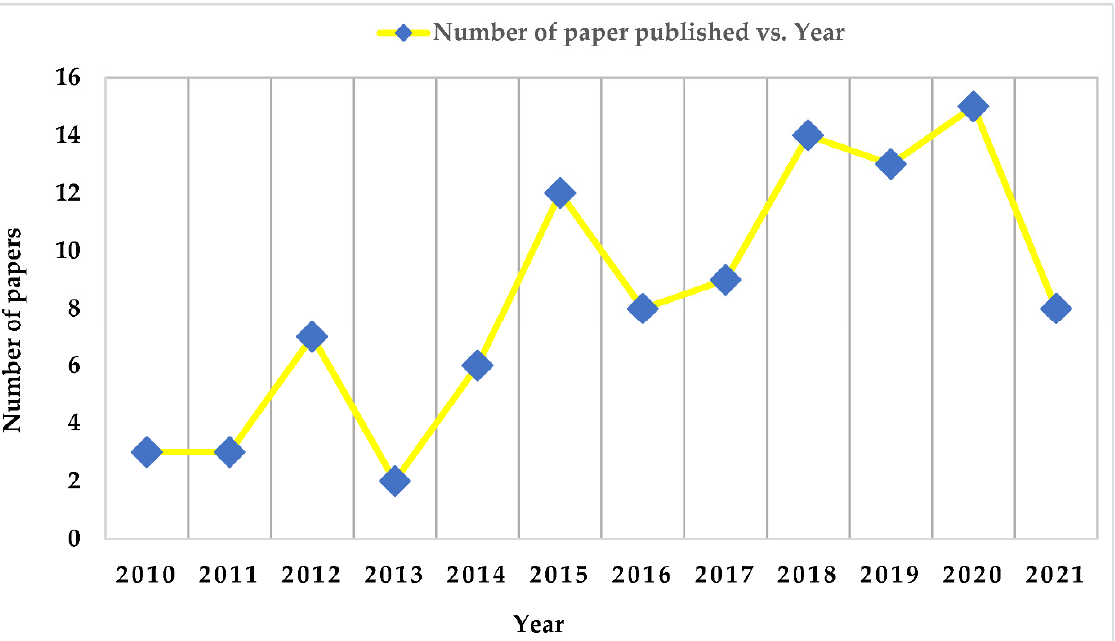
Figure 4. Distribution of 100 top-cited manuscripts from the year 2010 to 2021.